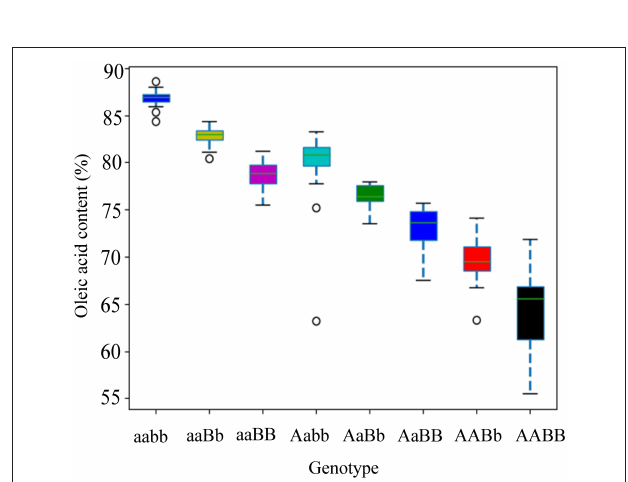
FIGURE 5 | Seed oleic acid content of different BnFAD2 genotypes distinguished by allelic KASP primers KASP421 and KASP 1073 in an F 2 population. The “A” and “B” represents wild type alleles by allelic KASP primers KASP421 and KASP 1073, respectively, while “a” and “b” represents mutated alleles by allelic KASP primers KASP421 and KASP 1073,